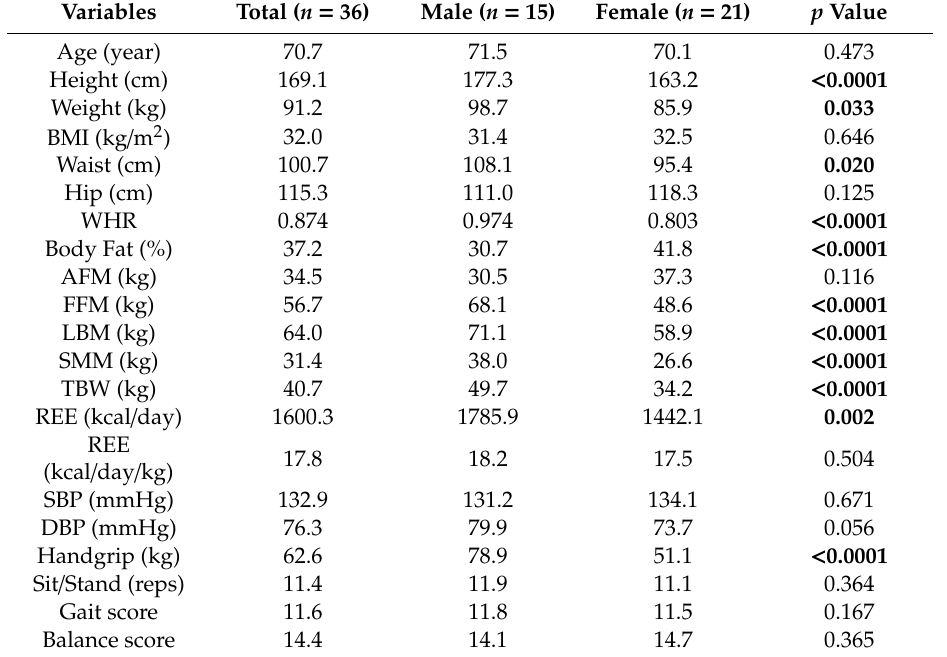
Table 2. Baseline characteristics of study participants. AFM: absolute fat mass, BMI: body